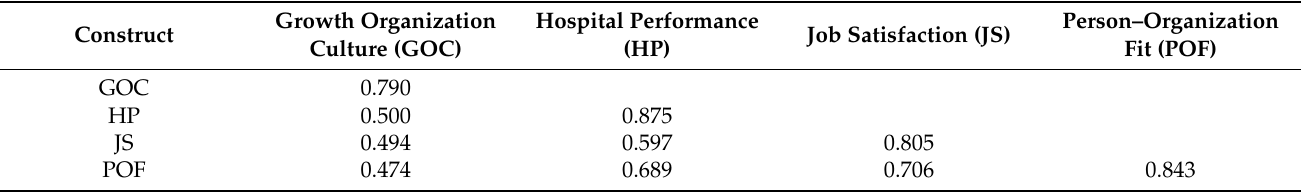
Table 3. Discriminant validity: Fornell–Larcker criterion.